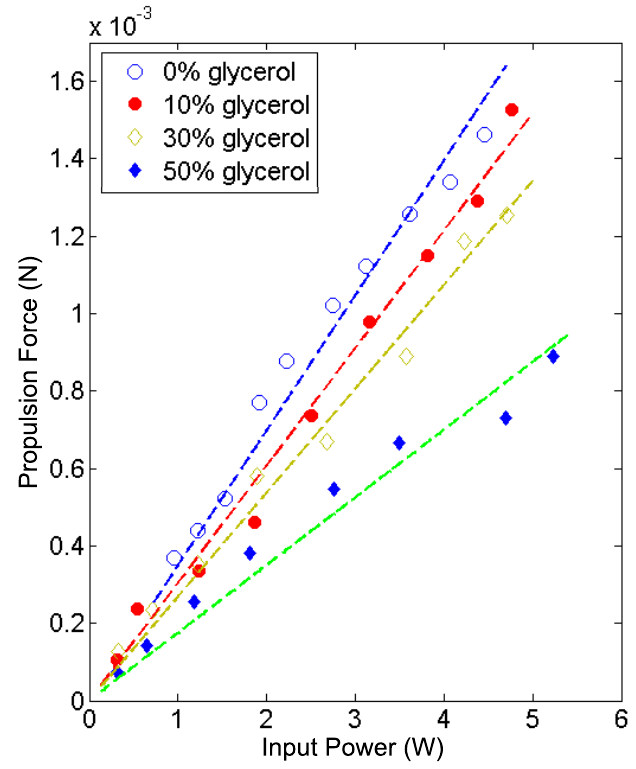
Figure A1. SAW propulsion force based on input power within different fluid media, indicating different propulsion force under various input power and fluid